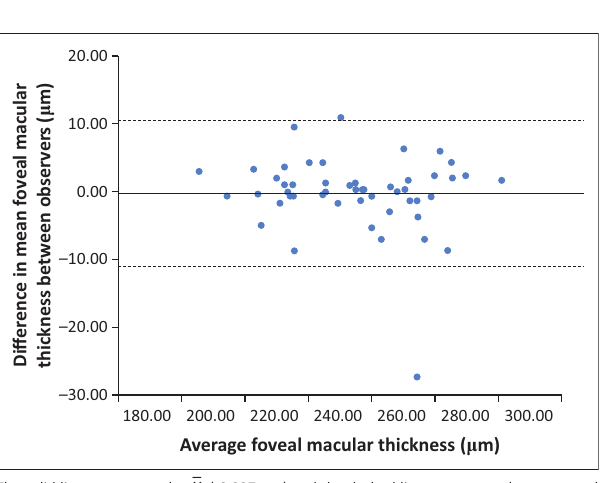
two observers. The Bland-Altman plot for the foveal macular